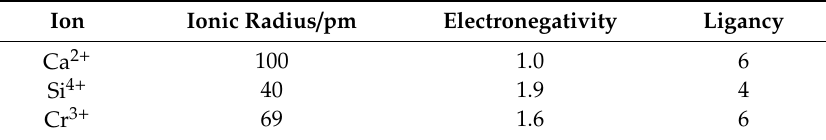
Table 4. Ionic radius, coordination number, and electronegativity of ions.